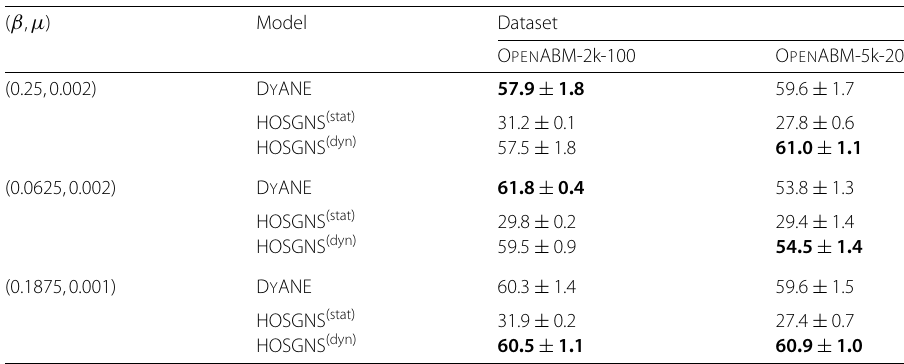
Table 5 Macro-F1 scores for classification of nodes in epidemic states according to different SIR epidemic processes for synthetic datasets. For each ( β , μ ) we highlight the best